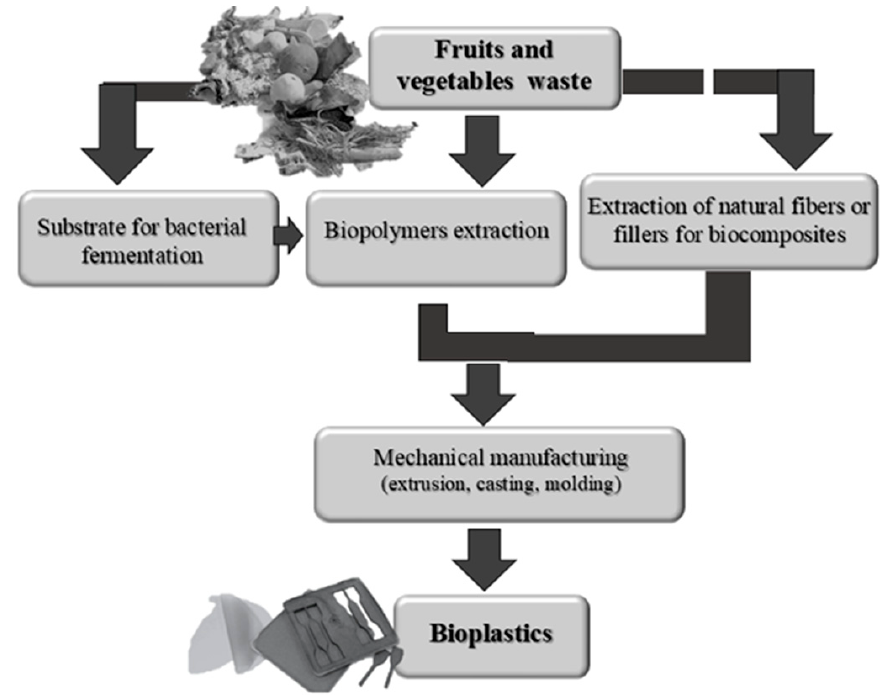
Figure 4. Conversion of food wastes into bioplastics could occur through biopolymers extraction and their mechanical manufacturing (extrusion, casting, molding, or combination of them). In more complex processes, food wastes are used as substrate for bacterial fermentation in order to produce biopolymers or as raw material for the extraction of other natural components, such as fibers, which act as reinforcing agents and/or natural filler of biocomposites.